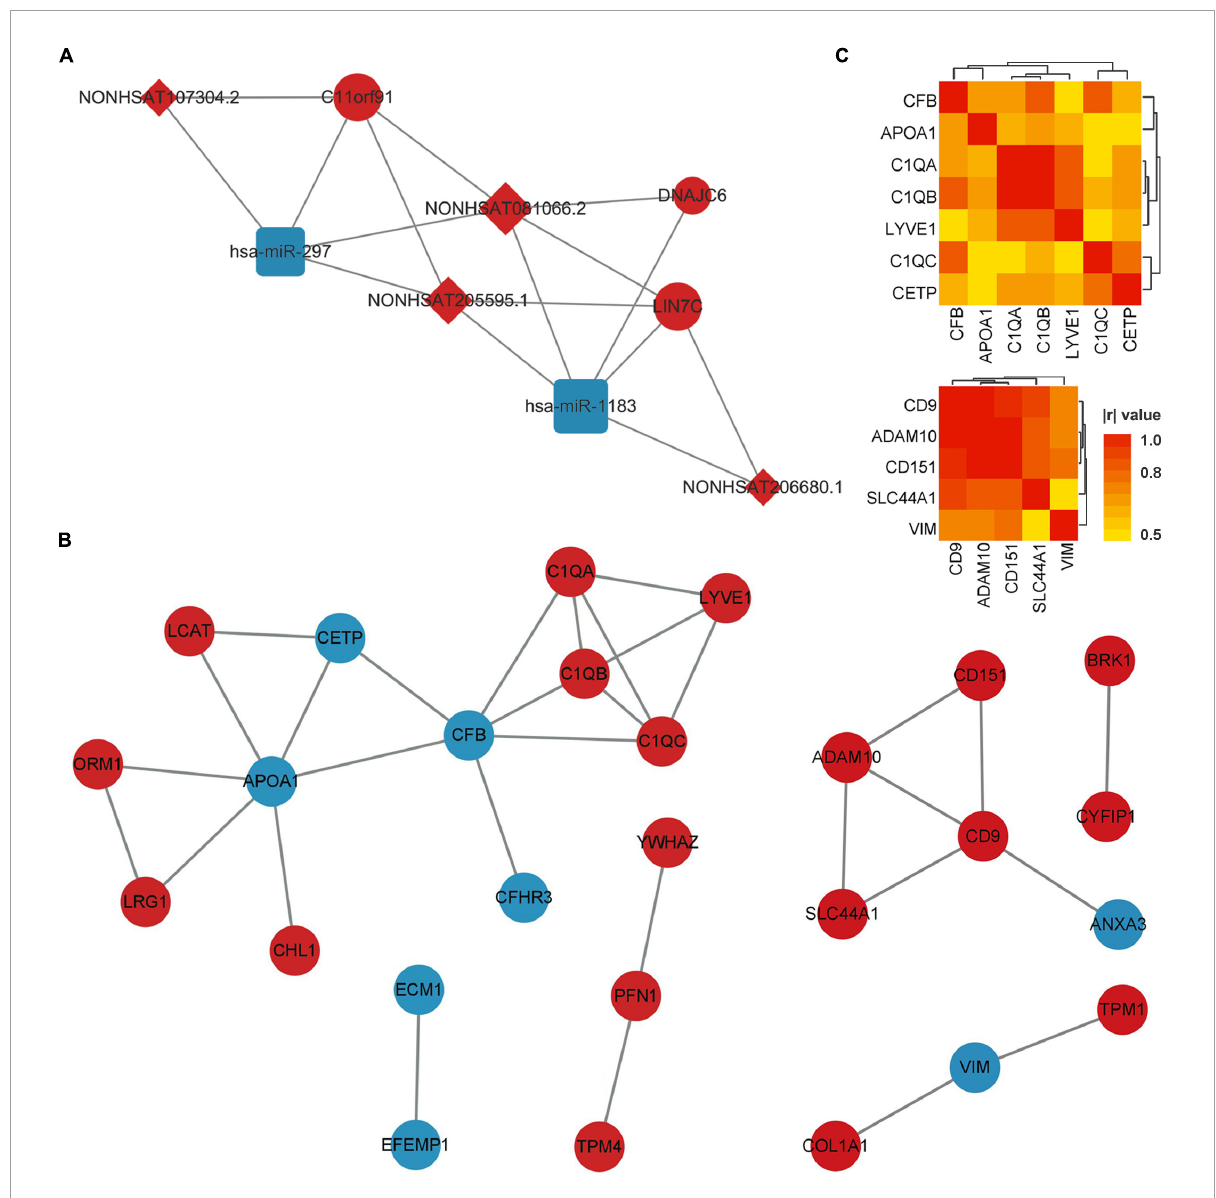
FIGURE3 ceRNA network of co-DERNAs and PPI network of DEPs in serum and exosomes. (A) ceRNA network of co-DERNAs. A circle represents a mRNA, a square represents a miRNA, a rhombus represents a lncRNA, and relationships between them are represented by edges. (B) PPI network of DEPs in serum and exosomes. Nodes represent the proteins, and edges represent relationships. Up-regulated genes and proteins are shown in red, and down-regulated genes and proteins are shown in blue. (C) Heatmap of correlations among the hub genes in the PPI network of DEPs in serum and exosomes. PPI, protein-protein interaction; DEPs, differentially expressed proteins; DERNAs, differentially expressed RNAs.